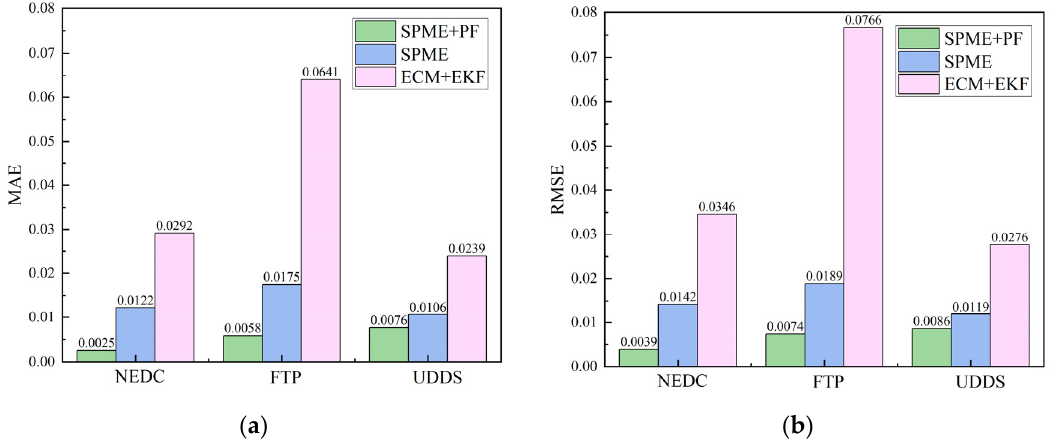
Figure 9. Errors comparison while the evaluation criteria are ( a ) MAE and ( b ) RMSE